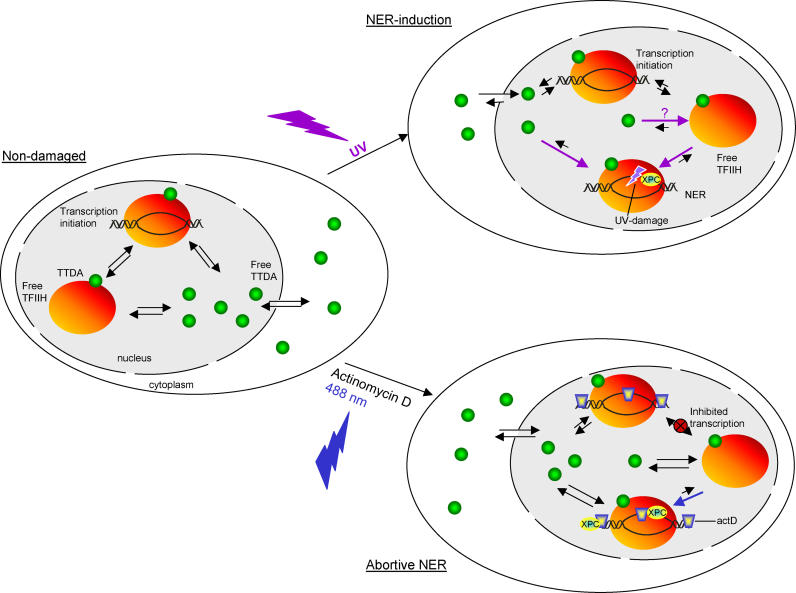
Model of TTDA Binding to TFIIH during Transcription, NER, and Abortive NERSchematic representation of a mammalian cell with the nucleus in gray and nuclear pores simplified by holes in the membrane. TTDA is represented as a green sphere, TFIIH is depicted as an orange ellipse, and XPC is illustrated as a yellow ellipse. Arrows indicate equilibrium (passage through) over the nuclear pores and equilibrium between different TTDA and/or TFIIH molecules. Colored arrows show the changes in the equilibrium after DNA-damage induction or ActD treatment. In “NER-induction” (right, upper), the UV lesion is depicted as a lightning-sign, in “Abortive NER” (right, bottom), ActD is depicted as a blue trapezoid, and the red cross represents the inhibition of transcription.